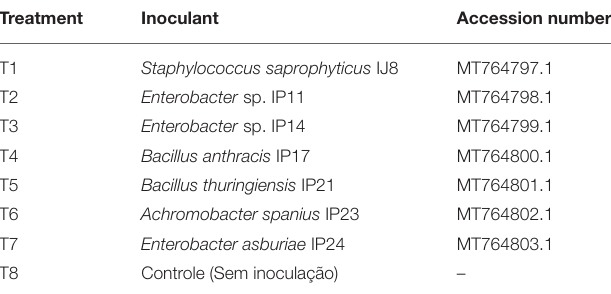
TABLE 2 | Sugarcane pot treatments and accession number of Rhizobacteria’s sequences deposited at NCBI.